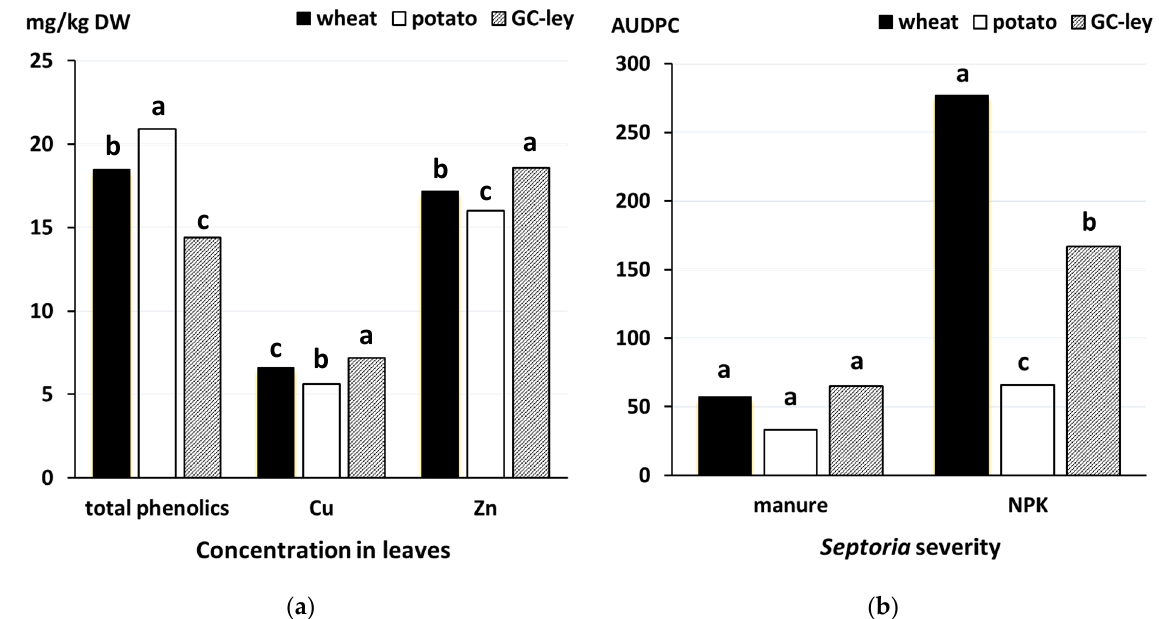
Figure 2. Effect of ( a ) preceding crops (wheat, potato, grass-clover [GC] leys) on total phenolic ( p = 0.001), Cu ( p = 0.002) and Zn ( p = 0.013) concentrations in wheat leaves and ( b ) fertilization regime (manure versus mineral NPK fertilizer applied at the same total N-input rate of 170 kg N hectare) and preceding crops on Septoria severity ( p < 0.001 for interaction) data from [33]. Means for the same composition parameter or fertilizer type labelled with the same letter are not significantly different (Tukey’s honest significant difference test, p < 0.05). AUDPC, area under the disease progress curve days x % severity.